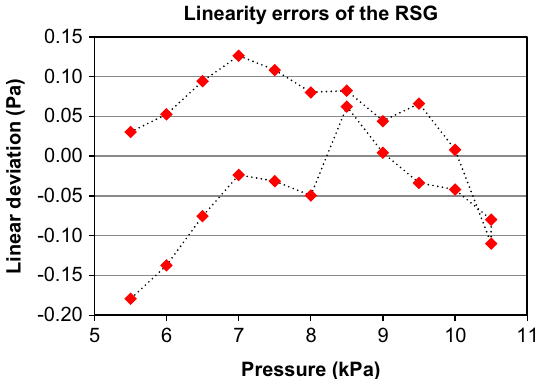
Fig. 4. Linearity deviation from a regression line of the lower range of the